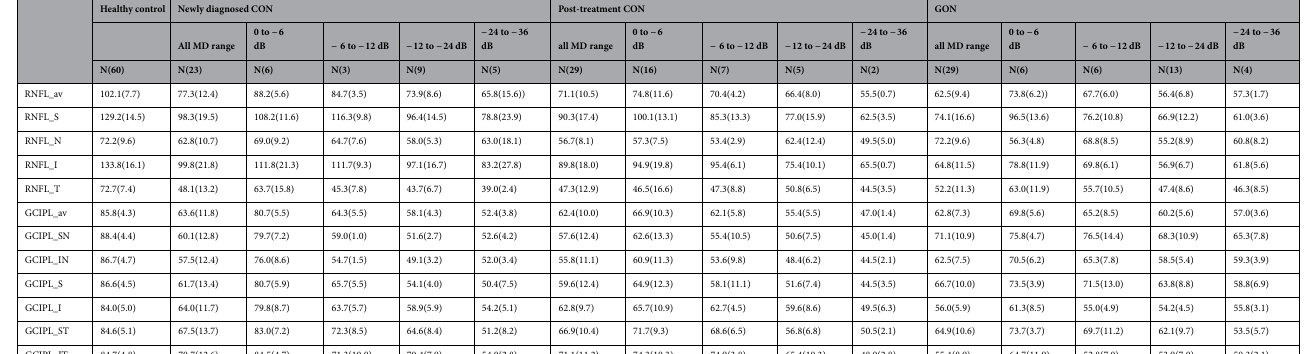
Table 2. Mean thicknesses and standard deviation of RNFL and GCIPL parameters of different stages of CON and GON at different MD losses severities ranges. All the number are mean in micrometer followed by standard deviation in parenthesis. GON glaucomatous optic neuropathy, CON compressive optic neuropathy, NOR healthy control, postRx post-treatment, newDx CON 23 of 34 newly diagnosed CON eyes show more proportional degree and pattern of structural thinning compared to the associated visual field losses, RNFL peripapillary retinal nerve fiber layer parameter, S superior quadrant, I inferior quadrant, N nasal quadrant, T temporal quadrant, GCIPL macular ganglion cell-inner plexiform layer parameter, SN supero-nasal sector, IN infero-nasal sector, S superior sector, I inferior sector, ST supero-temporal sector, IT infero-nasal sector, MD mean deviation, dB decibel, N(#) number of eyes in each category.